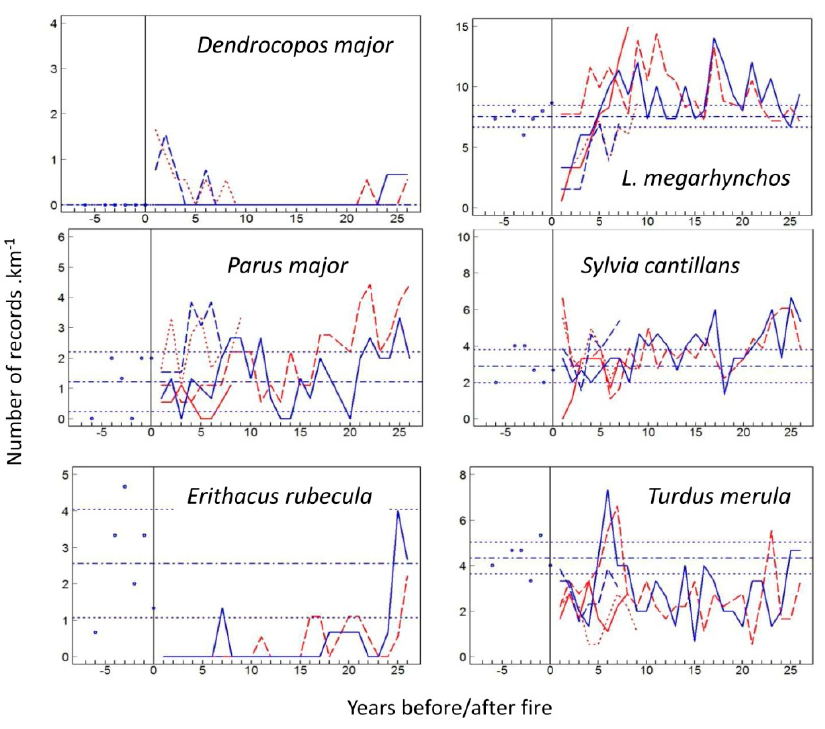
Figure A4. Postfire response curves of six other common bird species. Graphic conventions: see Figure A3.